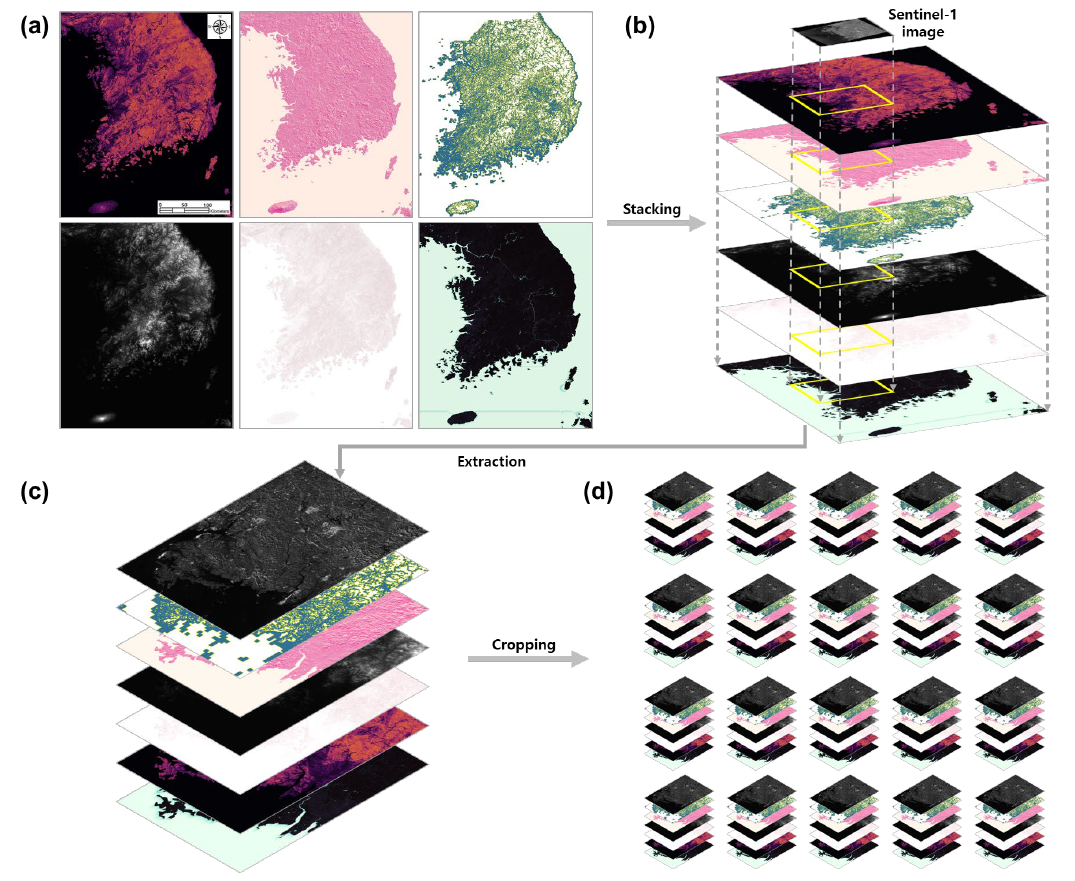
Figure 4. Geospatial layers produced for this research and stacking and cropping input layers: ( a ) produced geospatial layers for Republic of Korea, ( b ) stacked geospatial layers, ( c ) extracting stacked layers (around 30,000 × 20,000 pixels), and ( d ) cropping the stacked layers for deep learning model training (256 × 256 × 8 bands).